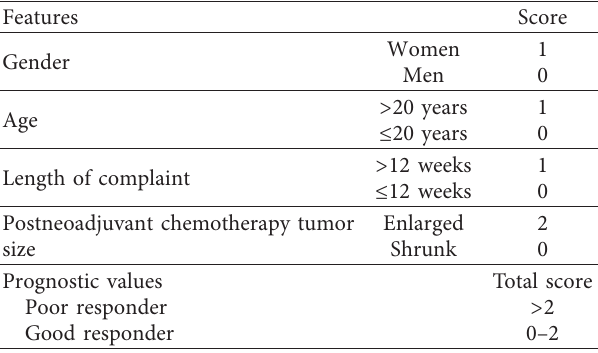
Table 4: Proposed scoring criteria for an integrated prediction of histopathological response to neoadjuvant chemotherapy.